Question: Give a one-sentence summary of this figure.
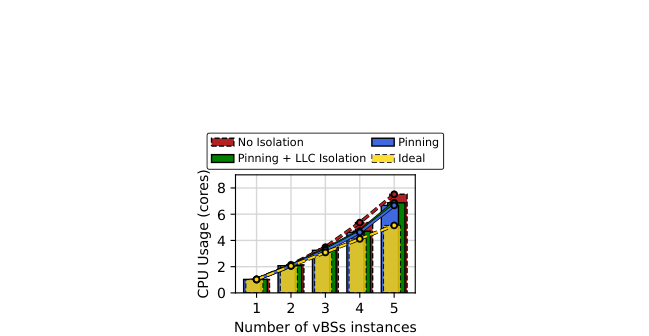
Answer: Comparison of the aggregated per-core usage with # of vBS instances showing the “No isolation”, the “Pinning” and the “Pinning + LLC isolation” scenarios.